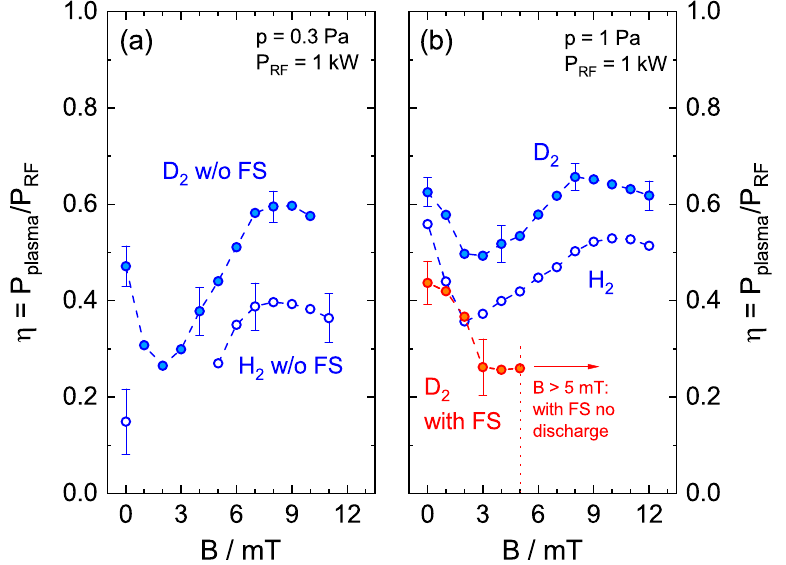
Figure 6. RF power transfer efficiency of the helicon discharge utilizing a Nagoya type III antenna in H 2 and D 2 for a varying magnetic field at 0.3Pa ( a ) and at 1Pa ( b